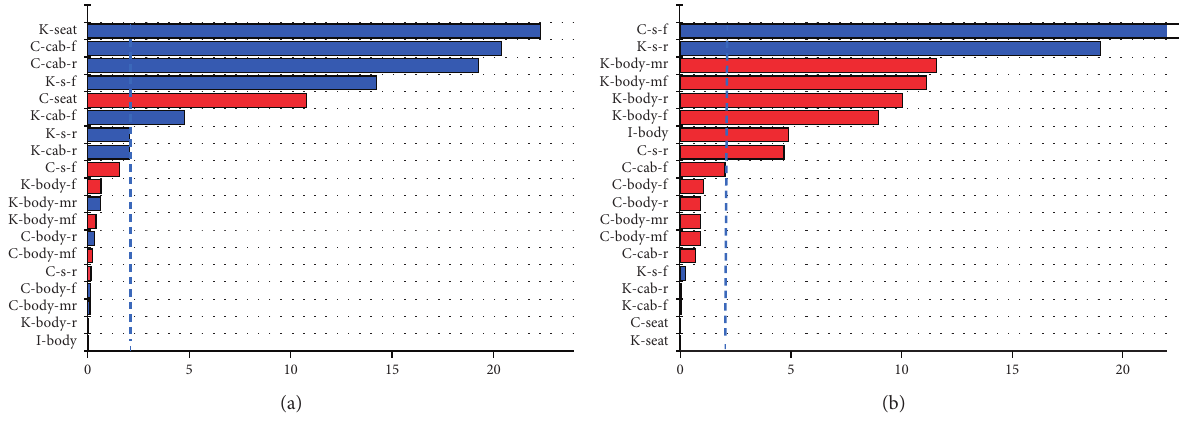
Figure 7: Standardized effects of design variables on the responses at (a) the human body and (b) the